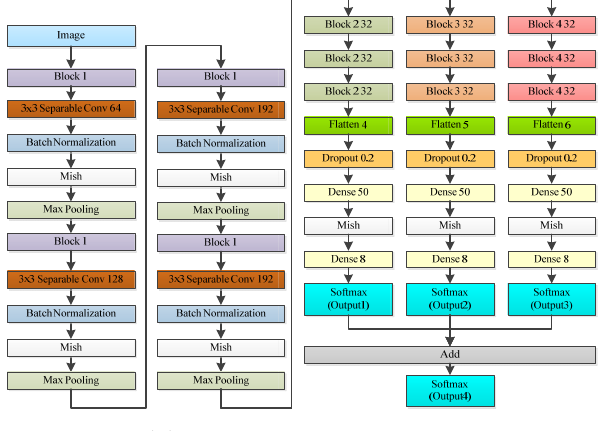
Figure 10. Four blocks of the model.